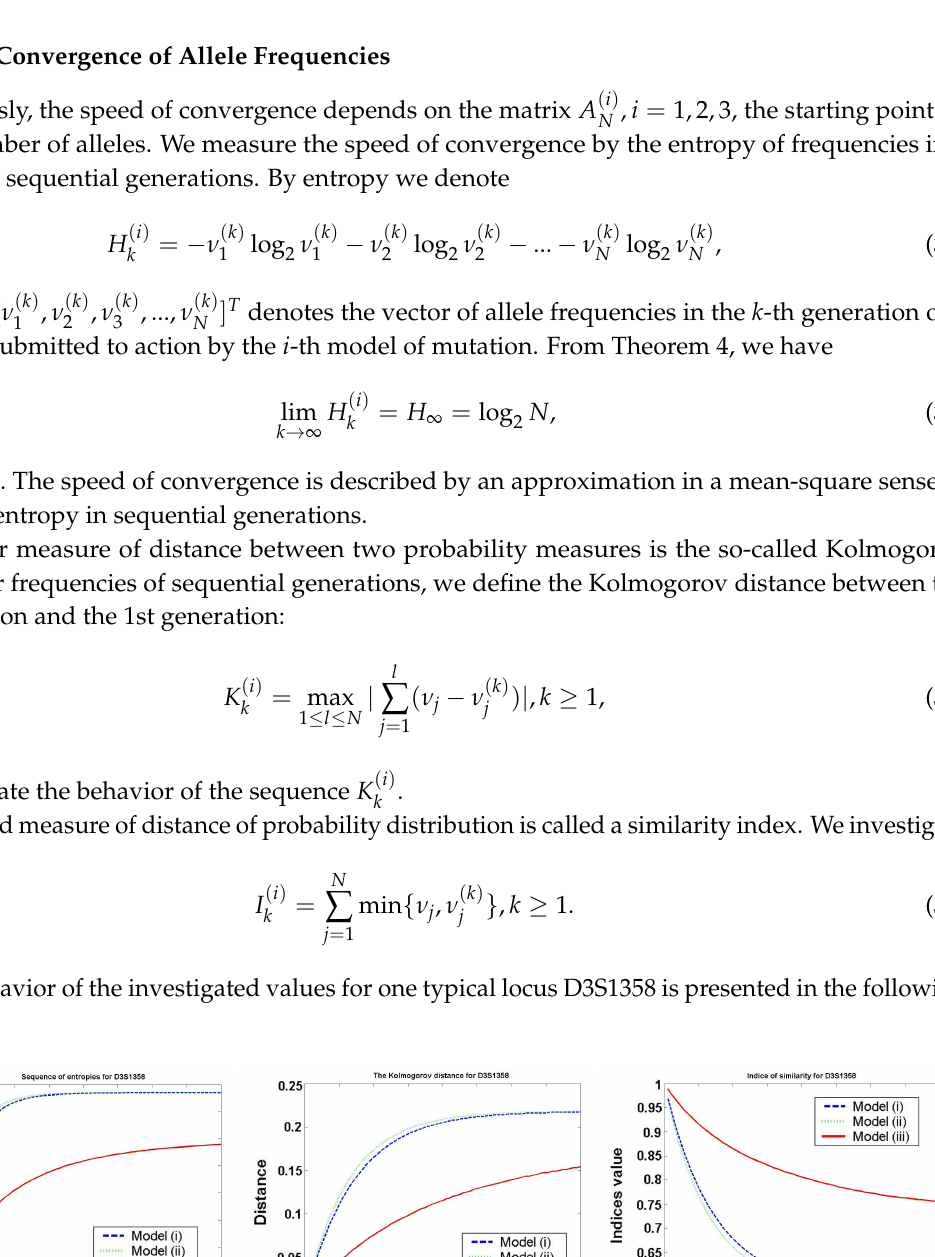
( i ) , Kolmogorov distance K k